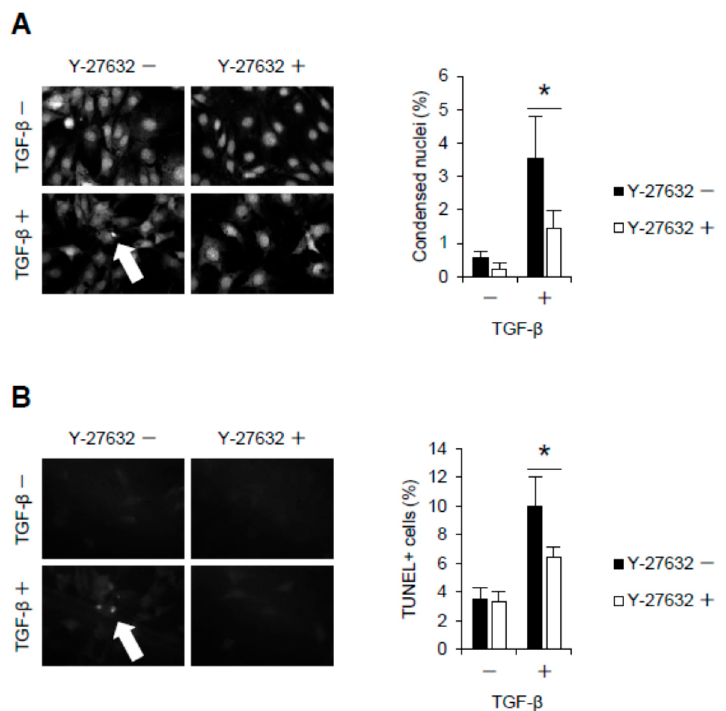
Figure 2. Rho-Kinase mediates podocyte apoptosis. ( A ) Representative photomicrographs and quantification of condensed nuclei in podocytes. E11 podocytes were pretreated with Y-27632 (10 µM) and then stimulated with TGF- β (5 ng/mL) for 24 h; ( B ) Microphotographs and quantification of TUNEL-positive apoptotic podocytes. Original magnification, ×400. * p < 0.05. The data are presented as means ± SD.